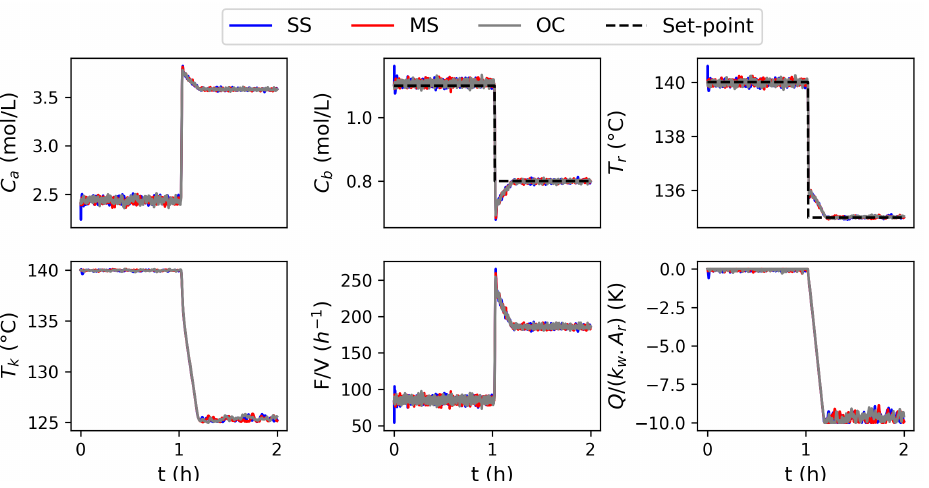
Figure 3. Results for the three NMPC approaches for Case 1, considering set-point